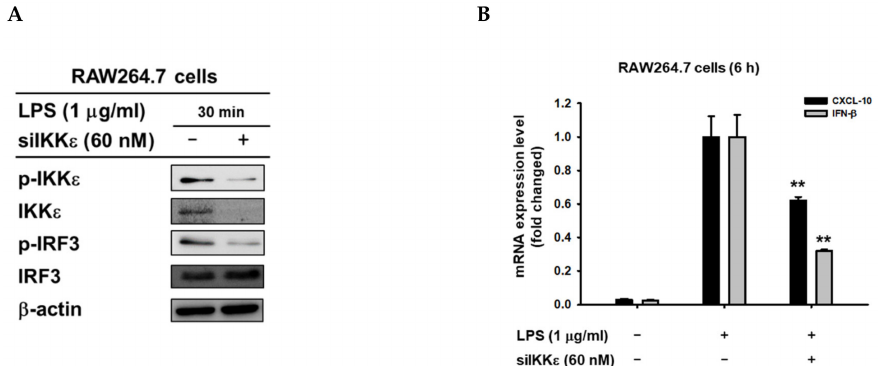
Figure 5. Knockdown of IKK ε negatively regulates IRF3 phosphorylation and the expression of IRF3-dependent genes. RAW264.7 cells were transfected with siRNA (60 nM) targeting to IKK ε for 48 h followed by treatment of LPS (1 µ g / mL) for indicated times. ( A ) Phospho- and total levels of IKK ε and IRF-3 were then determined by immunoblotting. ( B ) The mRNA analysis of CXCL-10 and IFN- β was performed using real-time PCR. ∗∗ p < 0.01 compared to the control group (LPS